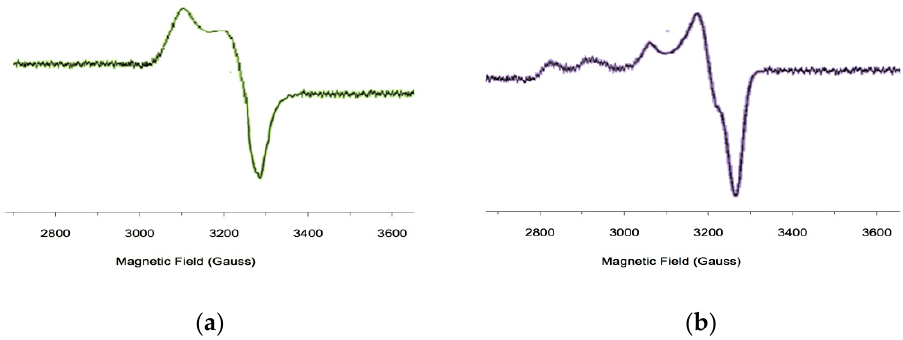
Figure 9. Powder Electron Paramagnetic Resonance (EPR) spectrum of Cu-[I-Cu] 6 ( a ) and [I-Cu] n ( b ) .